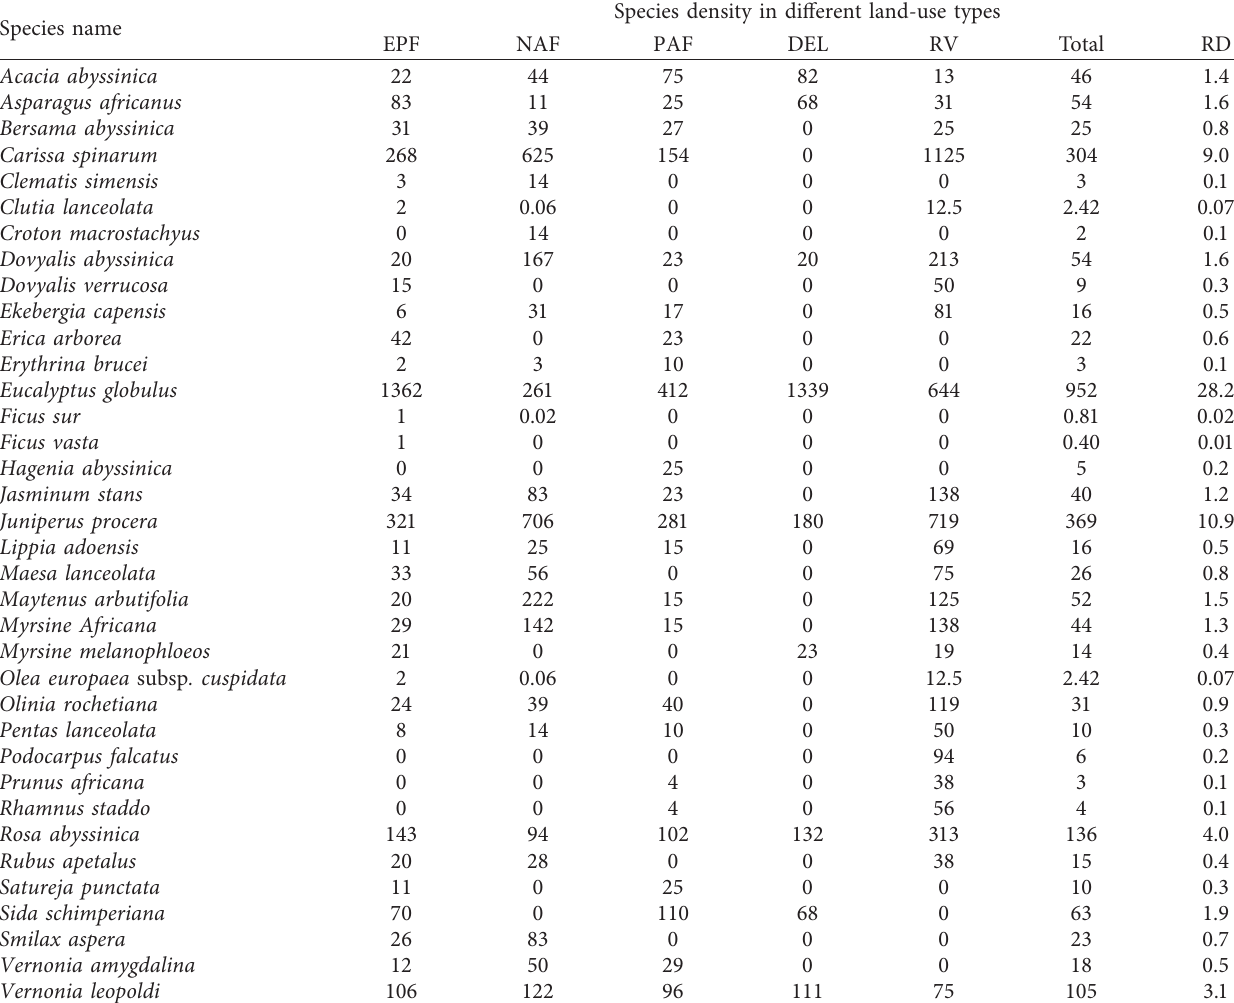
Table 4: Density of selected woody species in the study